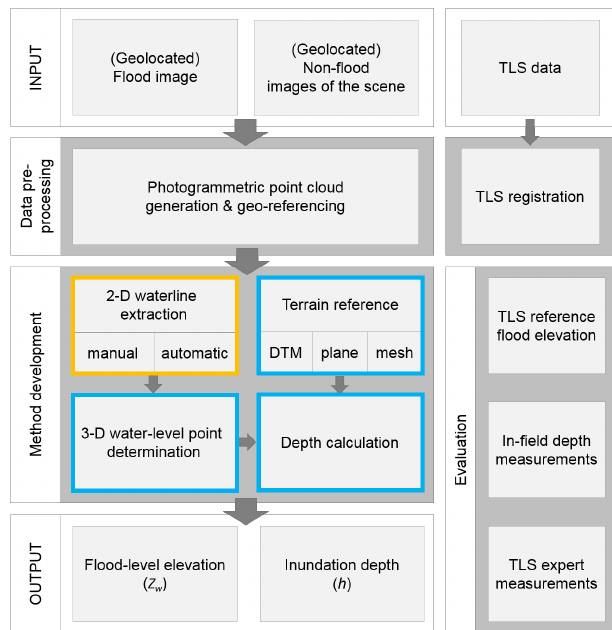
Figure 3. Workflow of this study, depicting the individual opera- tions of the proposed methodology. Blue indicates operations exe- cuted on point cloud level (3-D); yellow indicates operations exe- cuted on image level